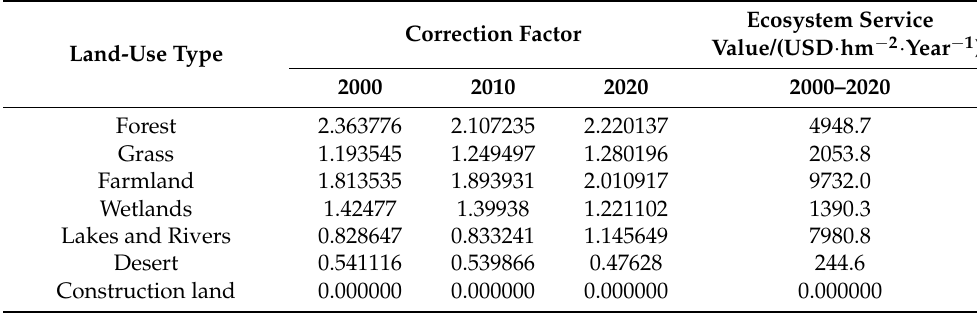
Table 3. China’s arid and semi-arid ecological regions in 2000, 2010, and 2020: correction coefficients and ecosystem service